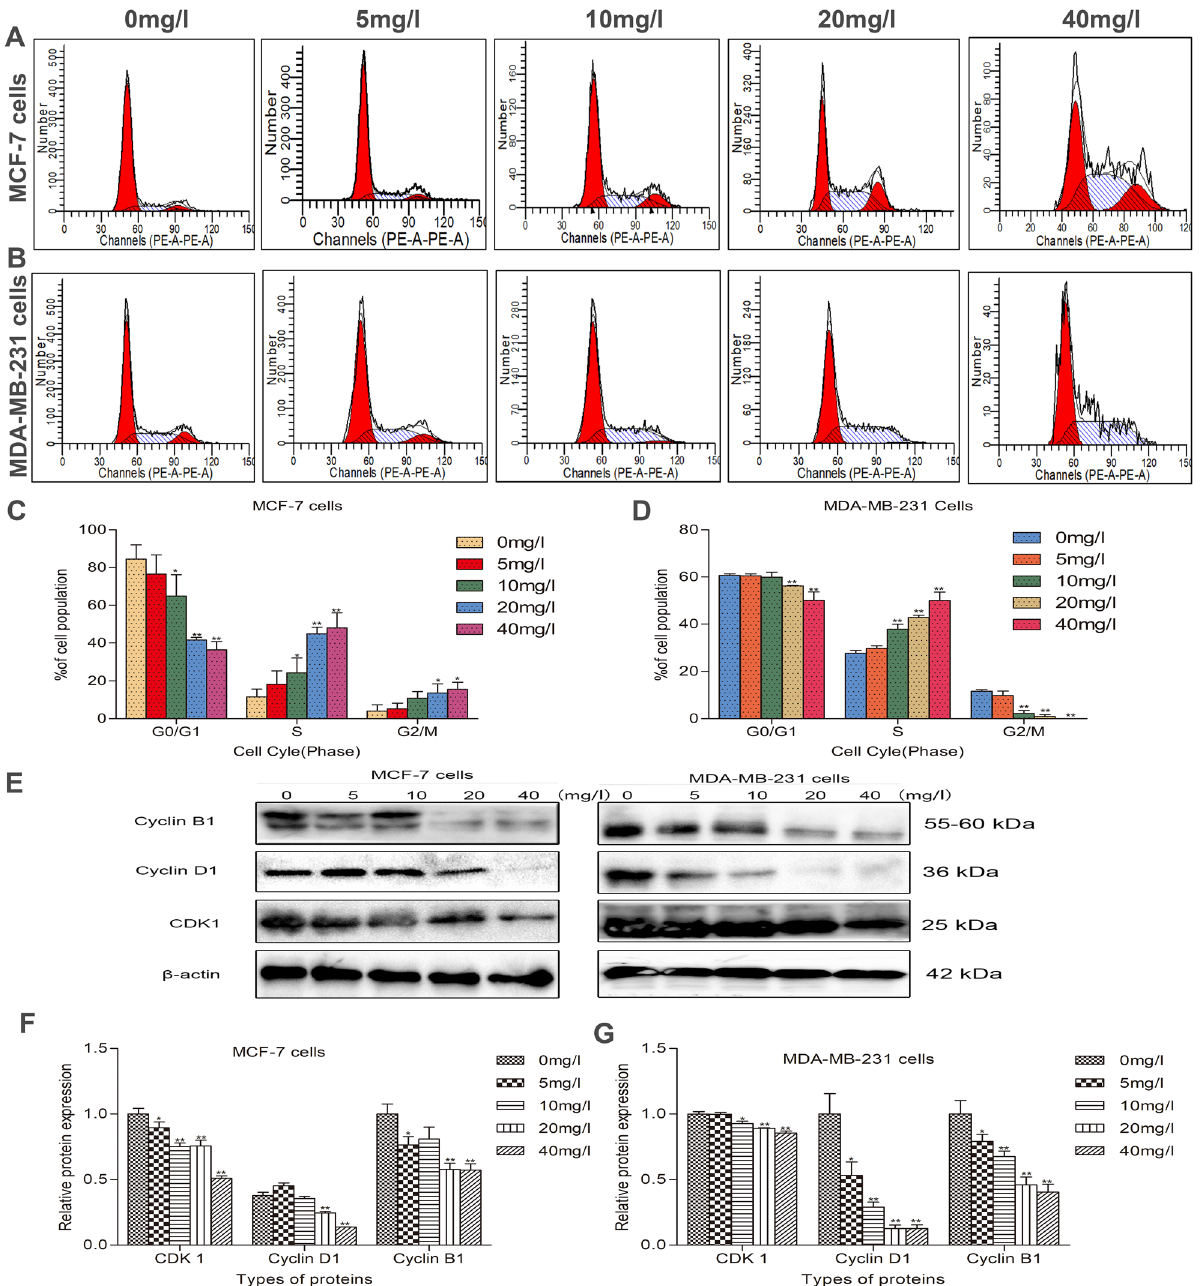
Figure 4. VALD-3 induced S and G2/M phase cell cycle arrest in MCF-7 cells and S phase cell cycle arrest in MDA-MB-231cells. Flow cytometry results showed that the cell cycle distribution of MCF-7cells ( A ) and MDA-MB-231cells ( B ) treated with VALD-3 for 48 h. ( C ) Percentages of cell population in each cell-cycle phase were analyzed in MCF-7cells ( C ) and MDA-MB-231cells ( D ) treated with VALD-3 for 48 h. ( E ) Levels of cell cycle related proteins CDK1, cyclinB1 and cyclinD1 proteins in VALD-3-treated breast cancer cells for 48 h were detected by western blotting. ( F – G ) The relative protein levels of CDK1, cyclinB1 and cyclinD1 proteins in VALD-3-treated breast cancer cells were analyzed. * P < 0.05, ** P < 0.01 compared with the control group. All data are presented as the mean ± SD from three independent